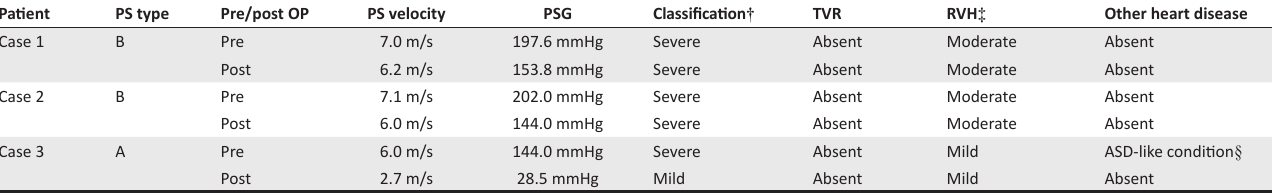
FIGURE 2: A transoesophageal echocardiography image showing the surgical procedure (an enlarged view is shown at the lower left). Case 1, TEE-guided hybrid balloon valvuloplasty was performed via thoracotomy on day 27; (a) Before hybrid balloon valvuloplasty, colour flow Doppler ( * : the stenotic portion of the pulmonary stenosis); (b) A 5-Fr sheath was inserted in the pulmonary stenosis site ( ** ), B-mode; (c) The balloon was inflated at the pulmonary stenosis site (dotted line: outline of the inflating balloon catheter), B-mode; (d) Following hybrid balloon valvuloplasty, the stenotic portion of the pulmonary stenosis was dilated ( † ). (Left, B-mode; Right, colour flow Doppler). TABLE 1: Echocardiographic findings for the three